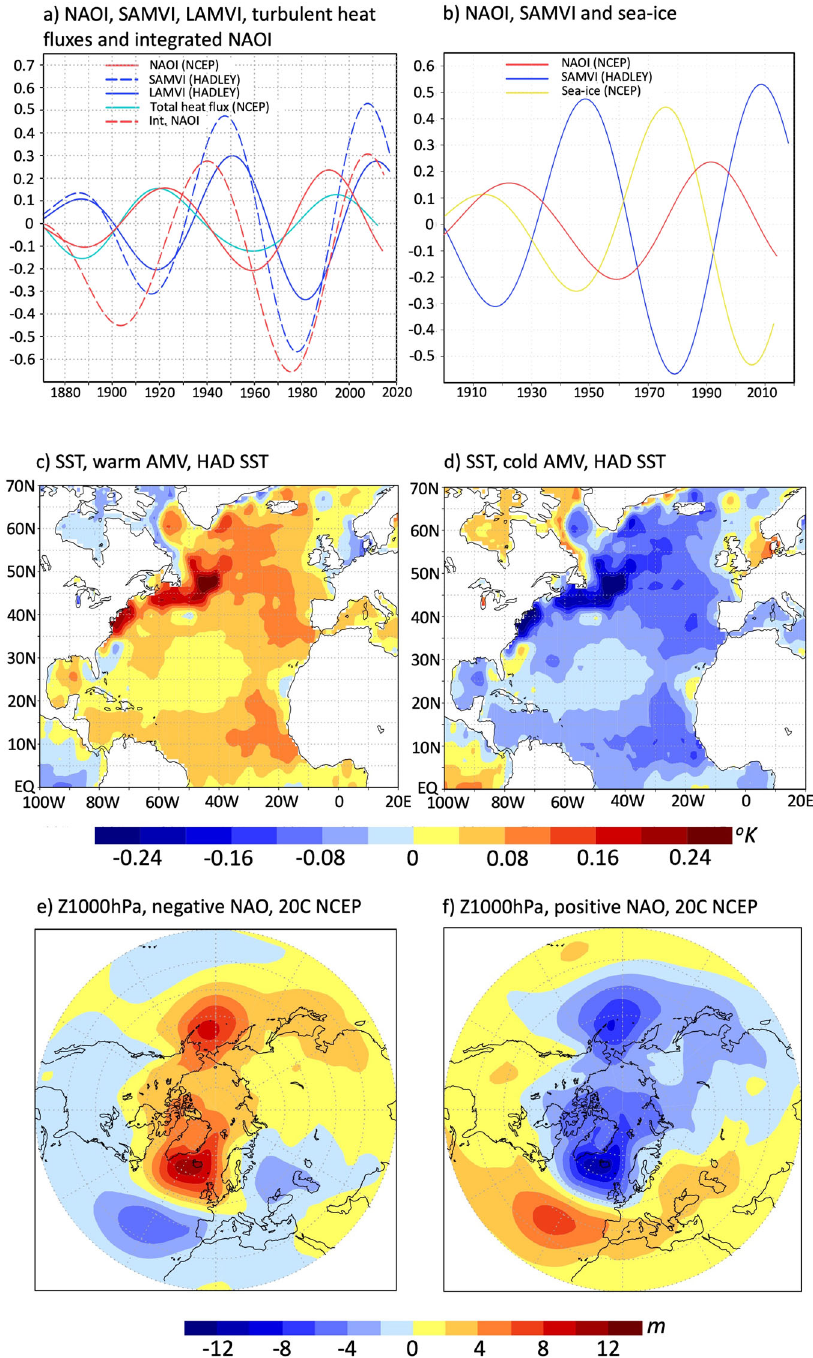
Fig. 1 Multidecadal NAO, AMV and Arctic sea-ice variability in the observations and reanalysis. a Multidecadal fl uctuations of the wintertime (JFM) standard AMVI (SAMVI, dashed blue, Methods), local AMVI (LAMVI, blue, Methods), NAOI (red), upward oceanic turbulent heat- fl uxes over Labrador Sea areas (green, 45 – 55 W and 45 – 60 N) and scaled time-integrated NAOI (dashed red). b Comparison between the wintertime (JFM) NAOI (red), AMVI (blue, Atlantic SST between 0 – 70 N) and the averaged sea-ice concentration over the Arctic region 60W-50E and 50 – 90 N. c , d Wintertime local multidecadal SST anomalies associated with strong multidecadal North-Atlantic Warming (years 1886 – 1889, 1949 – 1952 and 2010 – 1013) and cooling (years 1916 – 1919 and 1980 – 1983) respectively (in °C). e , f Wintertime 1000 hPa multidecadal geopotential height anomalies associated with strong positive (1921 – 1924 and 1989 – 1992) and negative (1887 – 1890 and 1959 – 1962) multidecadal NAO-phase (in m ). All indices in a and b have been standardized by dividing the resulting deviations from the mean by the standard deviation, in such way that the values express the portion of the standard deviation explained by the multidecadal